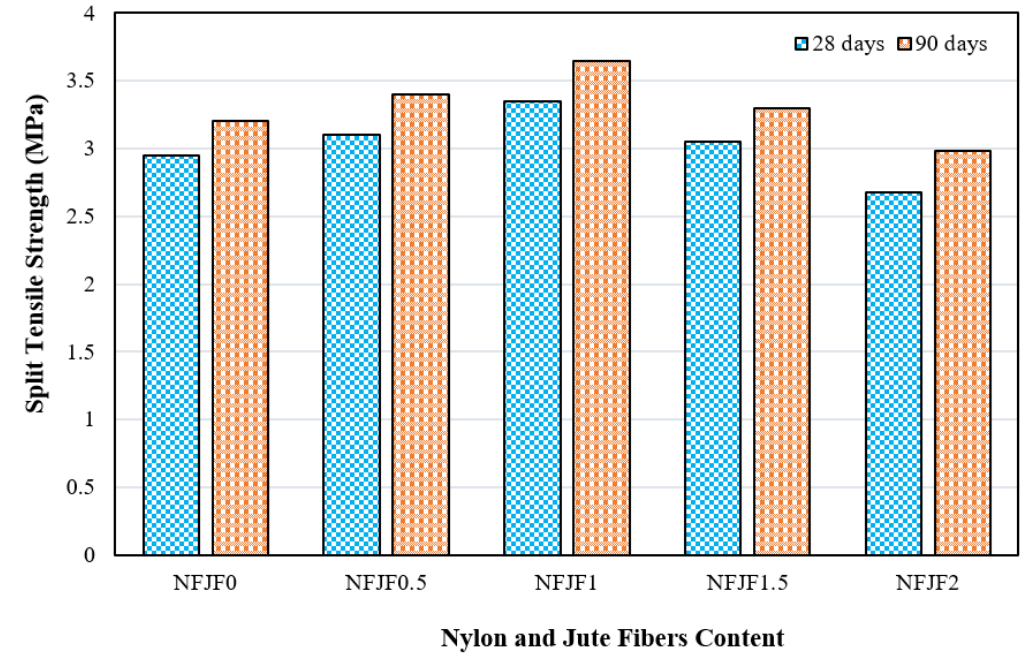
Figure 8. Splitting tensile strength of